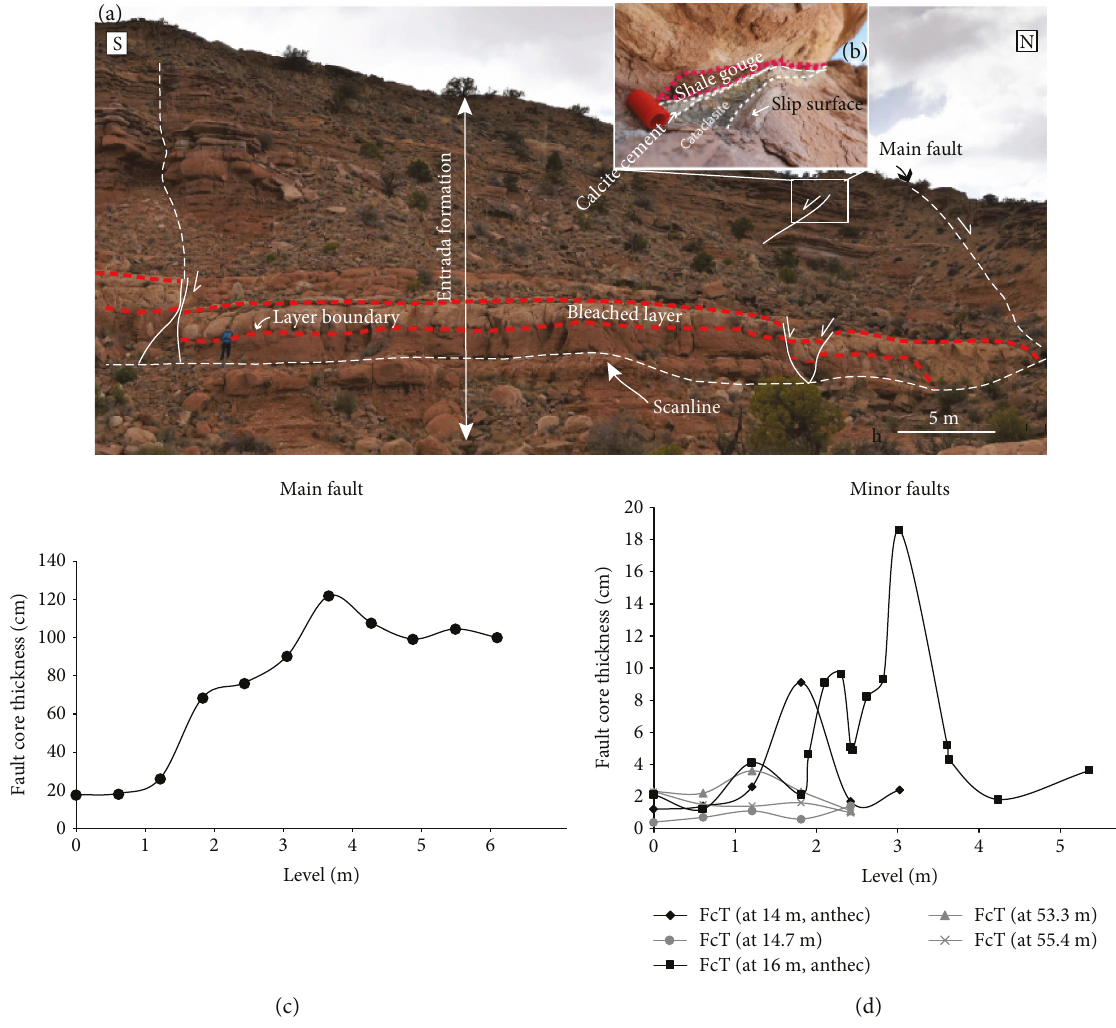
Figure 8: (a) Field locality in the Humbug Flats. Note the presence of main and minor faults that cross the 60m scanline. (b) A closeup showing an example of the internal structure of faults in this locality. The fault core includes cataclasite, shale gouge, and calcite cement. (c, d) Fault core thickness measurements at di ff erent levels for the main and minor faults in this